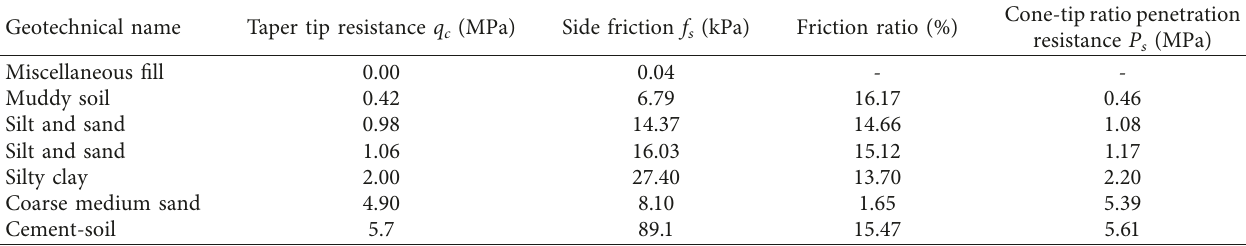
Table 3: Mechanical parameters of soil in the static penetration test.